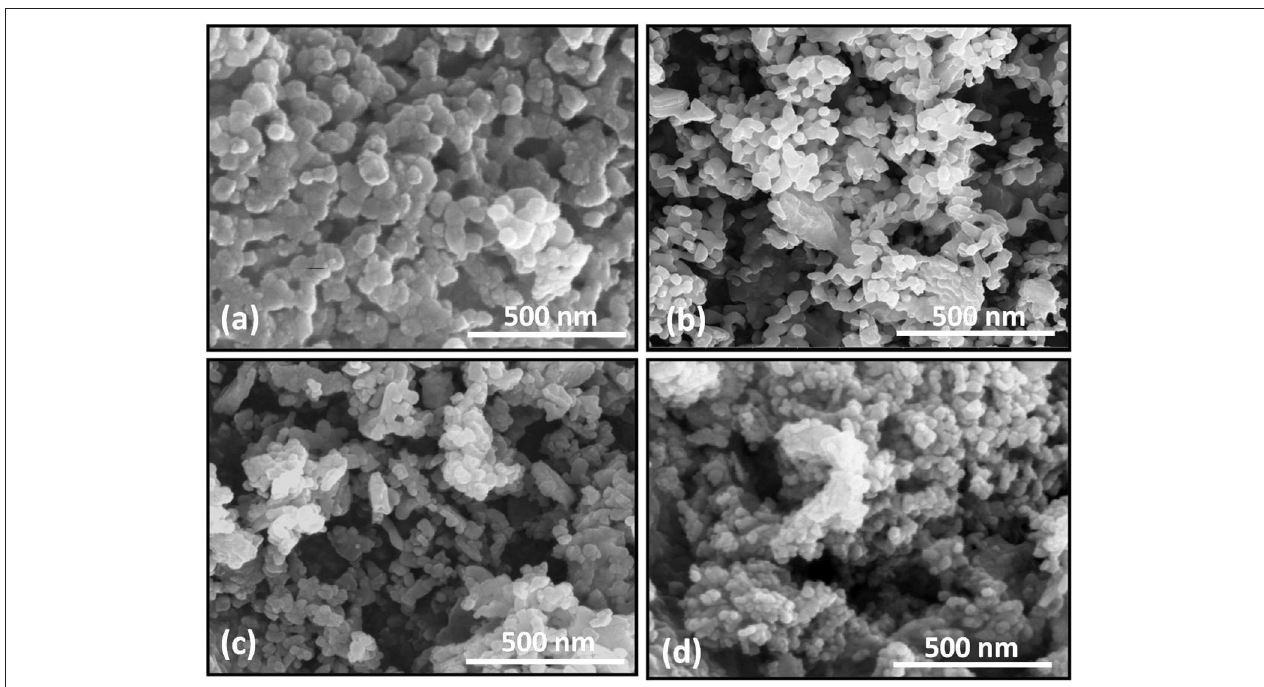
FIGURE 3 | SEM images of Bi 1